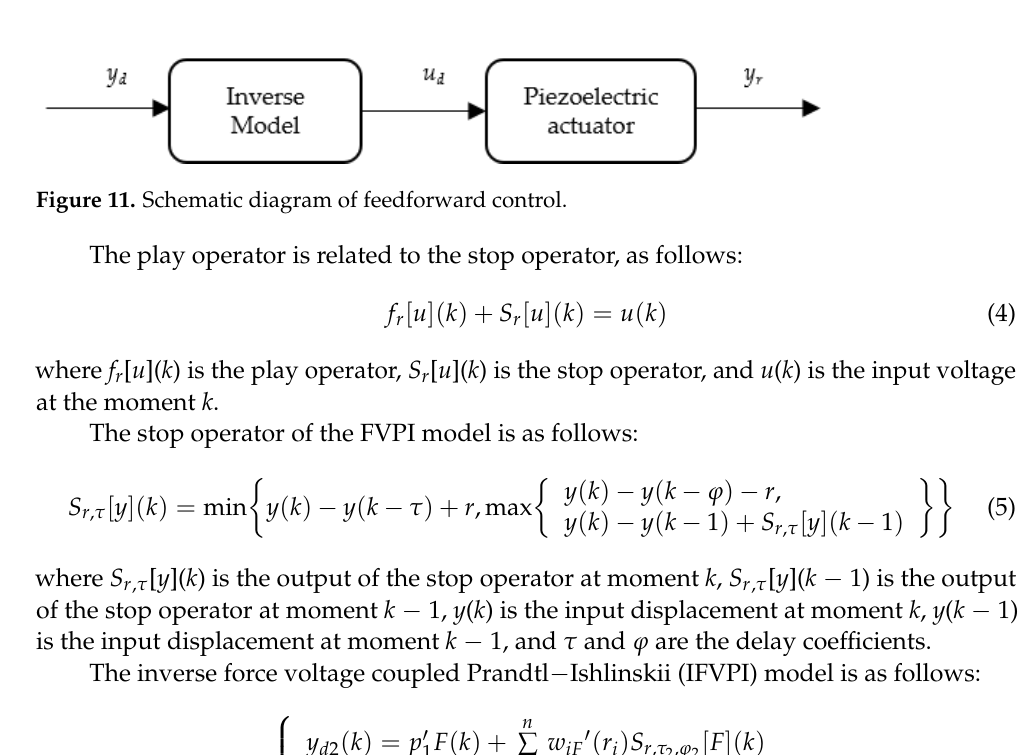
( d ) Figure 9. Error of two models at 250Hz under different loads: ( a ) spring 1; ( b ) spring 2; ( c ) spring 3; ( d ) spring 4. ( a ) ( b ) Figure 10. Two model error evaluation at different dynamic forces: ( a ) MAE; ( b ) MRE. 4. Feedforward Control 4.1. Feedforward Control Based on Inverse Model Feedforward control based on the inverse model is an effective method to suppress